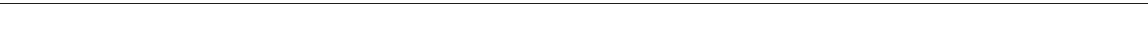
Fig. 3 Reductions in peptidoglycan cross-linking increase S. aureus EV production and size. a Dot blots were performed on JE2 EVs treated with subinhibitory concentrations of penicillin G (PenG) or erythromycin (Em) and probed with mouse EV antiserum. b EV protein abundance was quanti fi ed and expressed as ng EV protein ml − 1 culture. c EV production from S. aureus strains JE2, MW2, COL, or their isogenic penicillin-binding protein 4 ( pbp4) mutants was evaluated by dot-blotting EV suspensions or d by quanti fi cation of total EV protein yield. e EV production from strains JE2, COL, Newman, and their Δ tagO (WTA-de fi cient) or Δ dltA (lacking alanine modi fi cations on WTA) mutants was evaluated by dot-blotting EV suspensions or f by quanti fi cation of total protein yield. g The size distribution and h average size of EVs isolated from JE2, PenG treated JE2, and Δ pbp4 and Δ tagO mutants were measured by dynamic light scattering. i EV particles from JE2, PenG treated JE2, and Δ pbp4 and Δ tagO mutants were quanti fi ed by nanoparticle tracking analysis. Electron micrographs of j JE2 cells treated with PenG or k carrying a pbp4 mutation are shown. Scale bar, 200 nm. Dot immunoblot assays were performed at least twice with similar results; a representative blot is shown. EV protein yield and EV particle quanti fi cation experiments were calculated from at least three independent experiments and expressed as mean ± s.e.m. The data were analyzed using one-way ANOVA with Dunnett ’ s multiple comparison test (Fig. 3b, h, i) or using Student ’ s t -test (Fig. 3d, f). * P < 0.05, ** P < 0.01, *** P < 0.001, **** P <